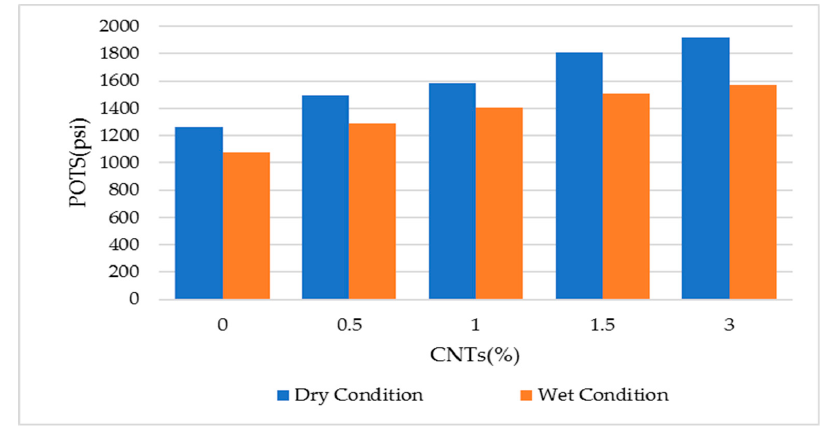
Figure 16. Comparison of POTS in 24 h dry and wet conditions.